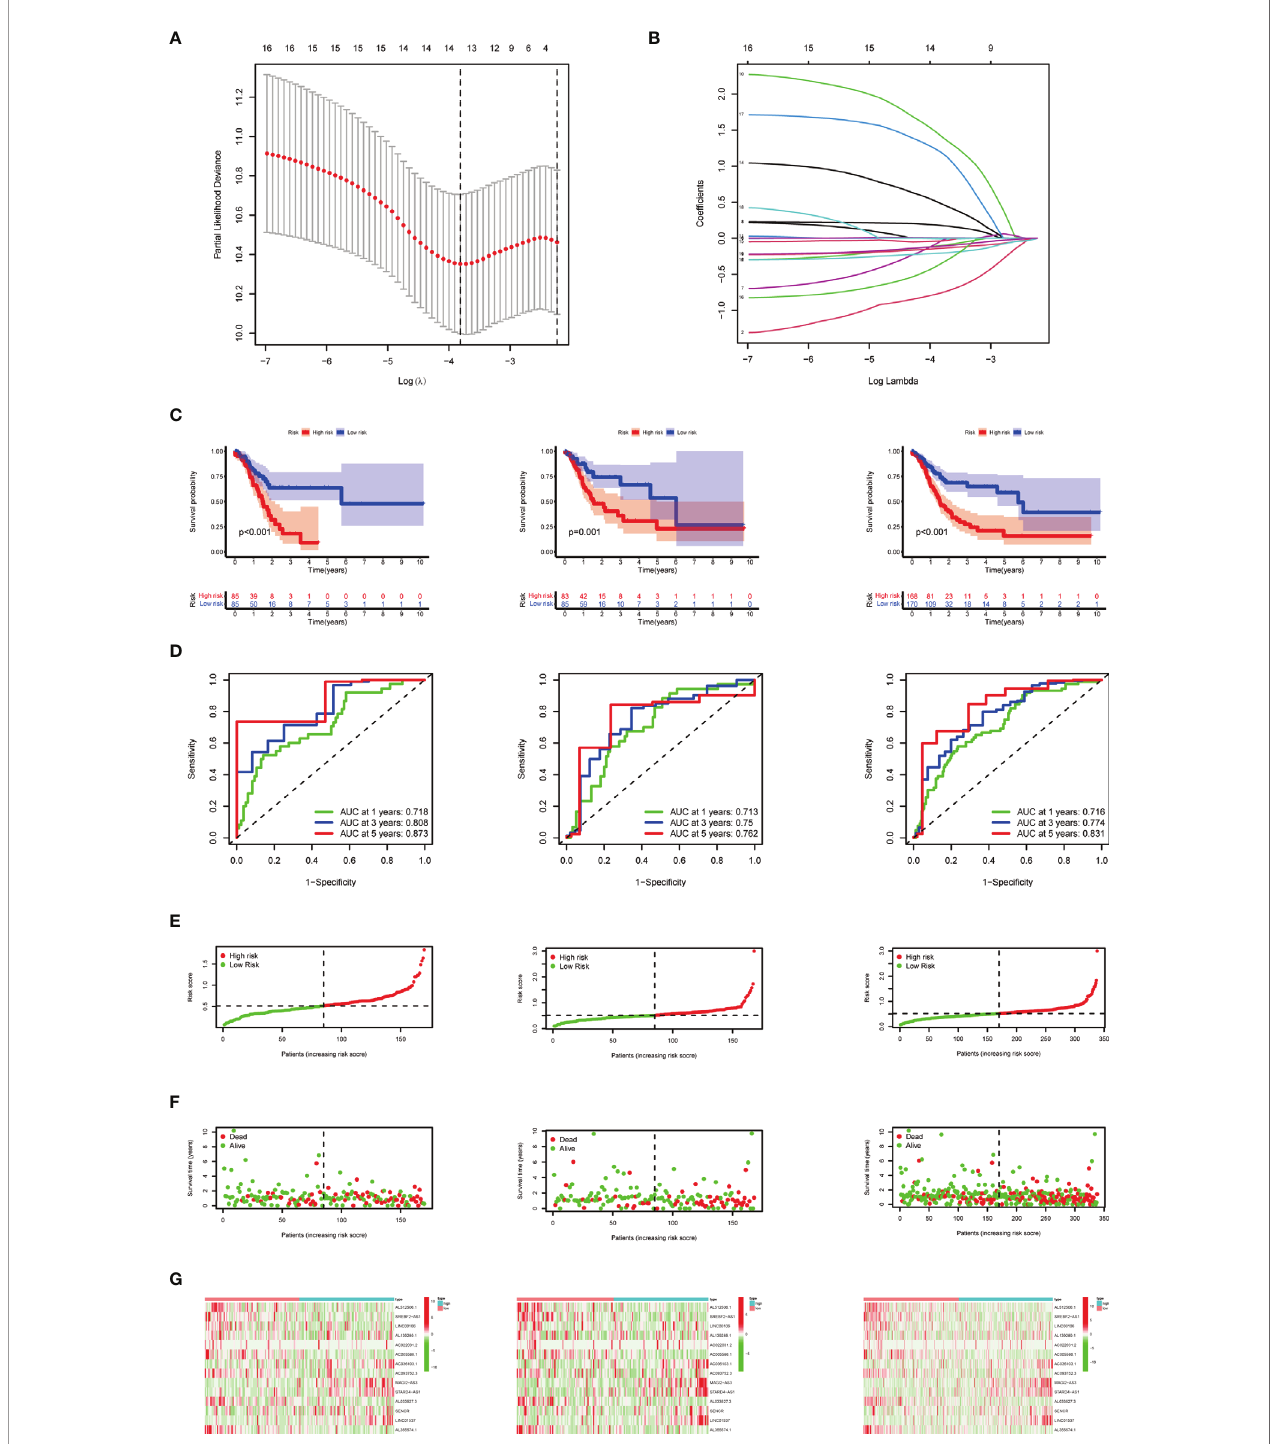
FIGURE 6 | Construction and veri fi cation of the m 6 A-related lncRNA prognostic signature. (A) The point with the smallest cross-veri fi cation error corresponds to the number of factors included in the LASSO regression model. (B) The lines of different colors represent the trajectory of the correlation coef fi cient of different factors in the model with the increase of Log Lamda. (C) Kaplan-Meier analysis of patients in the high-risk and low-risk groups in the training group, the test group, and the combined group. (D) ROC analysis of 1, 3, and 5 years in the training group, the test group, and the combined group. (E) Distribution of patients with different risk scores in the training group, the test group, and the combined group. (F) OS status of patients with different risk scores in the training group, the test group, and the combined group. (G) Heat map of the prognostic signature scores in the training group, the test group, and the combined